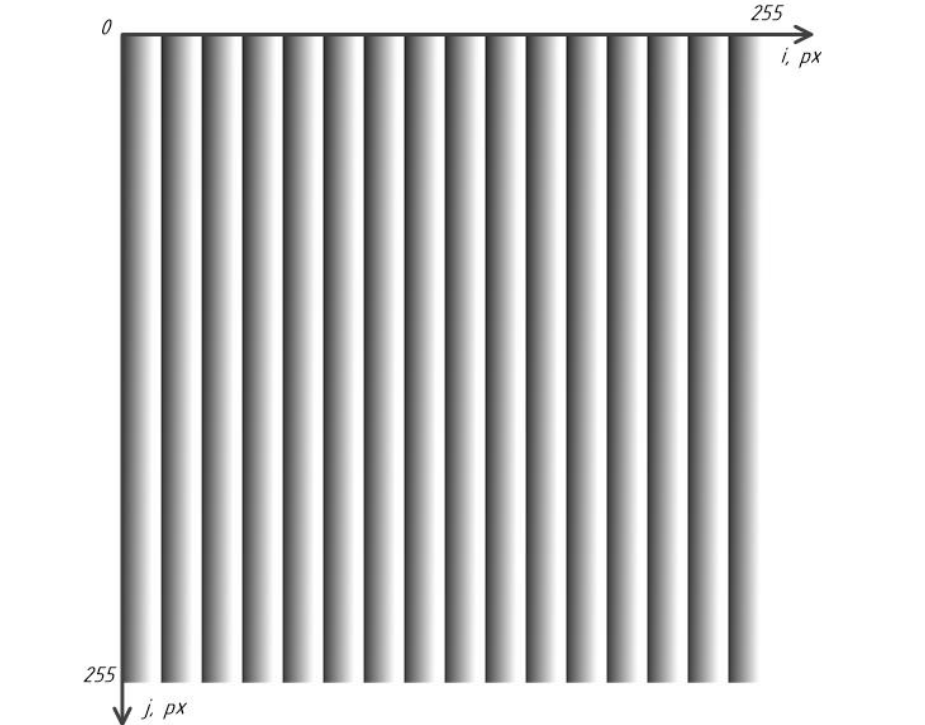
Figure 4. Color spectrum of DICOM images: i – the value low byte of the gray16 format pixel, i = 0, 255 ̅̅̅̅̅̅̅̅ , j – the value of high byte of the gray16 format pixel, j = 0, 255 ̅̅̅̅̅̅̅̅